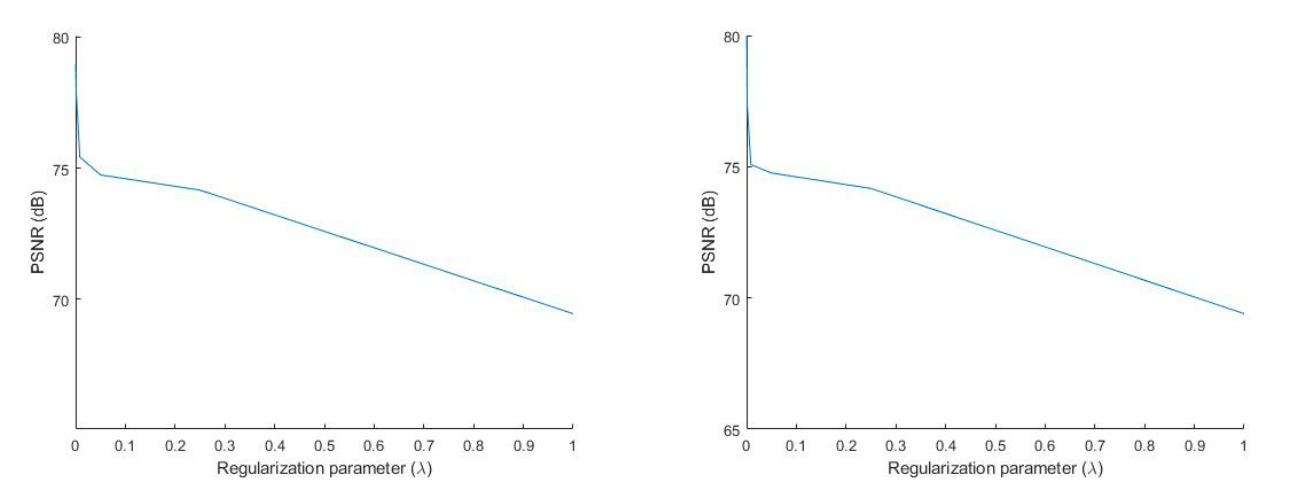
Figure 2. PSNR of Algorithm 6 (left) and Algorithm 9 (right) with respect to λ at the 200th